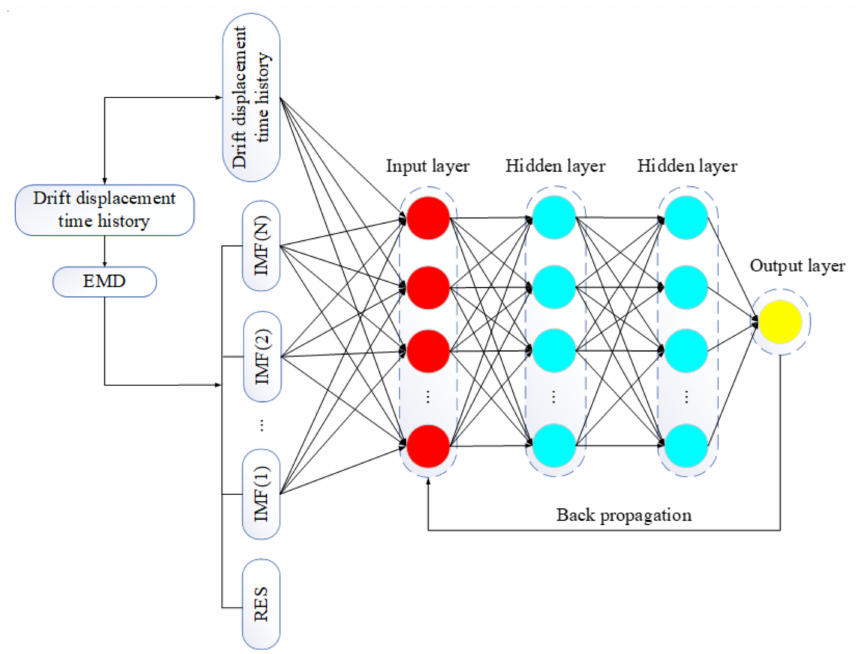
Figure 4. EMD–DNN baseline correction model.